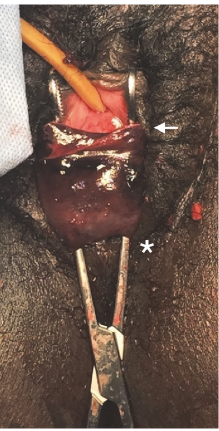
Figure 2: Six-week postoperative speculum evaluation of a multi- parous woman who suffered a partial posterior cervical avulsion 10 days following removal of an ultrasound-indicated